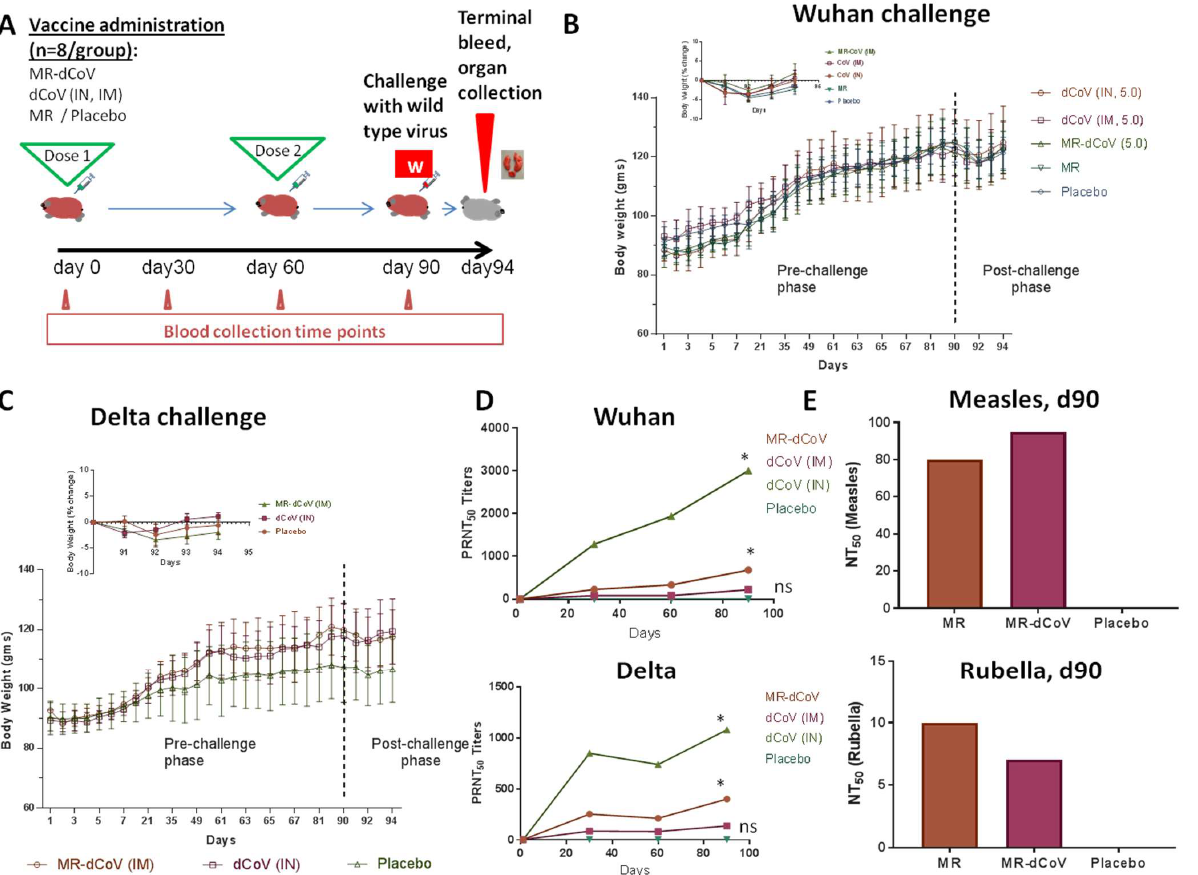
Figure 3. Challenge with Wild-type SARS-CoV-2 Variants: ( A ) Schematic representation of the experimental design of challenge studies. ( B ) Weights of hamsters in grams throughout the observation period and inset showing % weight change after challenge with the Wuhan strain from day 90 to day 94 (1–4 days post challenge). Line graph with Mean and SD is shown for each group, dCoV administered via IN routecircle) or via IM route (square), MR-dCoV (triangle), MR (inverted triangle) and Placebo (diamond). ( C ) Weights of hamsters in the challenge study of the Delta strain and inset showing % weight change after challenge with the Delta strain from day 90 to day 94 (1–4 days post challenge). Line graph with Mean and SD is shown for each group, MR-dCoV (triangle), dCoV (circle) and Placebo (inverted triangle). ( D ) Neutralizing antibody titers in hamster sera samples collected from day 0 to day 90 in the pre-challenge phase and tested against the Wuhan strain (top) or the Delta strain (bottom) estimated via PRNT assay. Rise in antibody titers was observed in the hamsters vaccinated with MR-CoV and dCoV (IN) with respect to placebo. One-tailed, paired Student’s t test, * ≤0.05, ns = no significant difference observed with respect to placebo controls. ( E ) Neutralizing antibody titers against measles virus and rubella virus in hamster sera on day 90 tested using MNT assay.